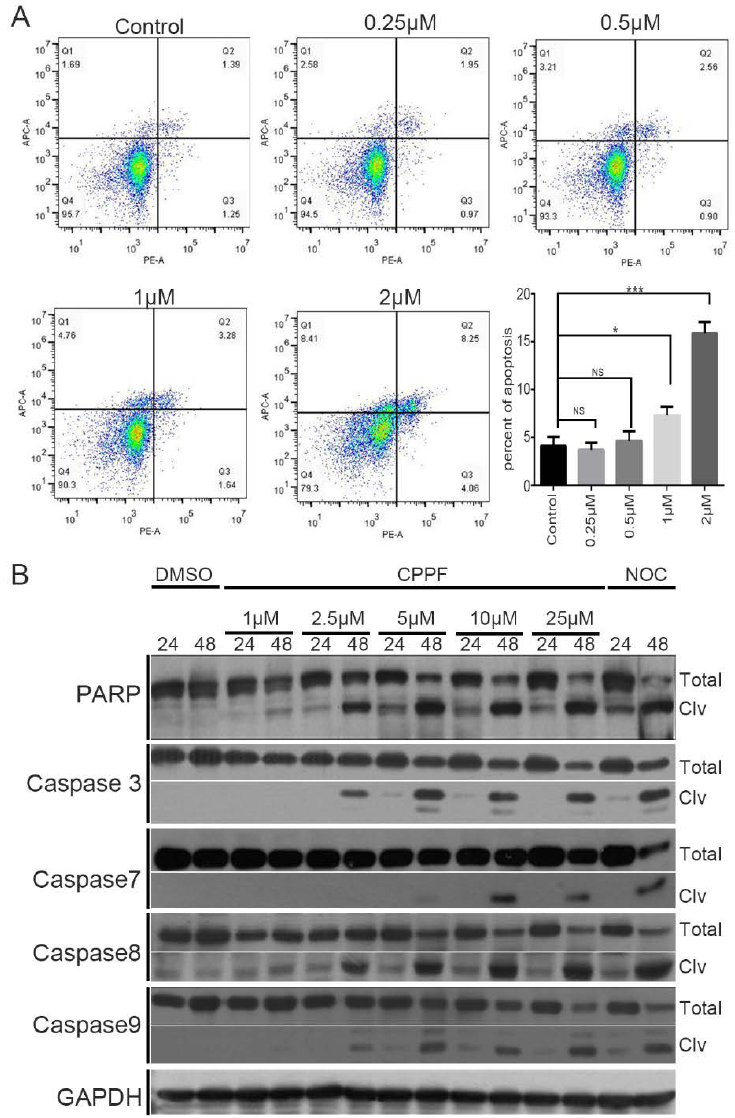
Figure 5. CPPF causes apoptotic cell death. ( A ) HeLa cells treated with various concentrations of